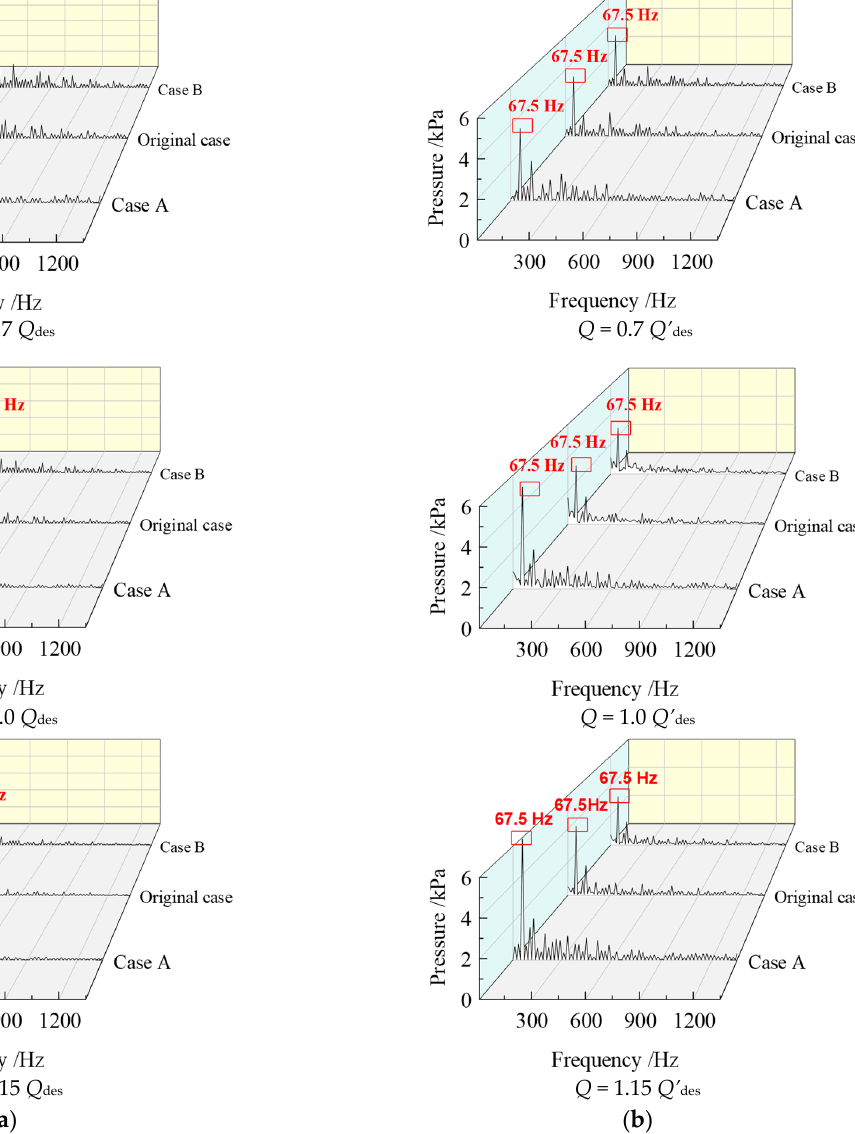
Figure 20. The frequency domain of pressure signal on A1 of three cases under ( a ) forward and ( b ) reverse conditions.